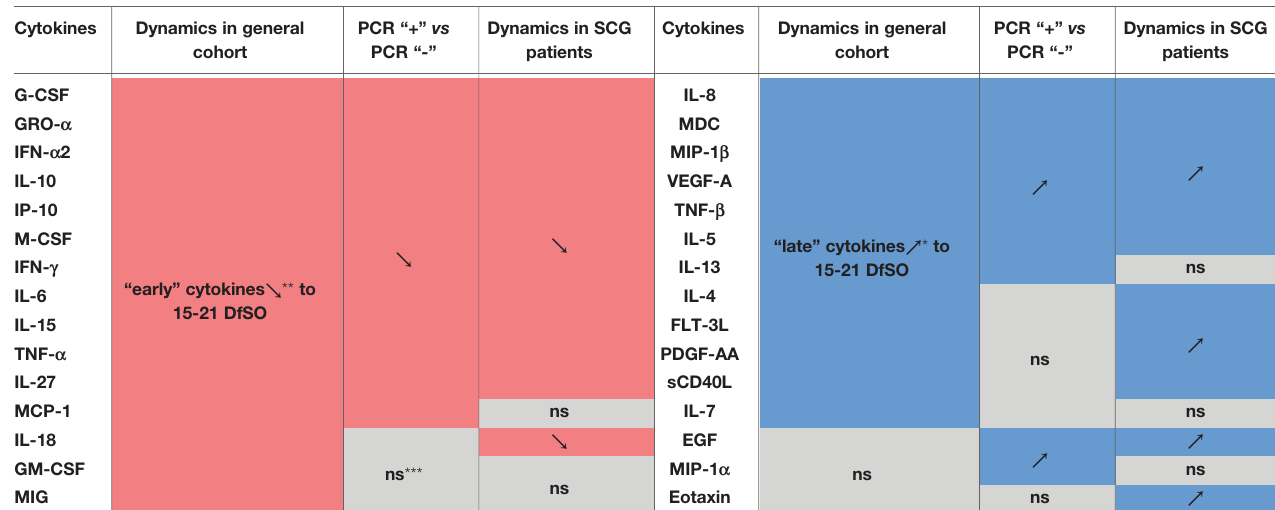
TABLE 1 | Summary of cytokine level changes revealed by the three